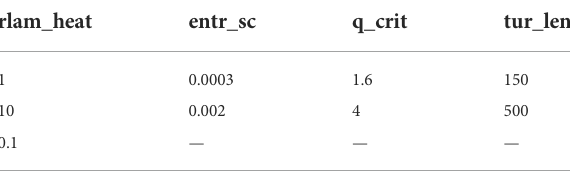
TABLE3ParametervaluesoftheCOSMOmodelphysicspackageused for the ensemble members of the COSMO EPS. Parameter rlam_heat is the scaling factor for the thickness of the laminar boundary layer for heat; entr_sc is the mean entrainment rate for shallow convection; q_crit is the critical value for normalized over-saturation; and tur_len is the asymptotic maximal turbulent distance. The fi rst line of numbers gives the default values also used in the